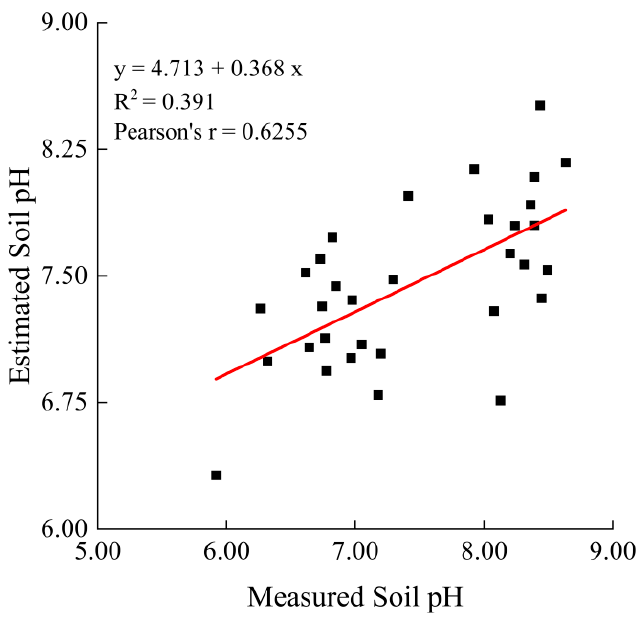
Figure 2. Scatter plots of predicted model accuracy.